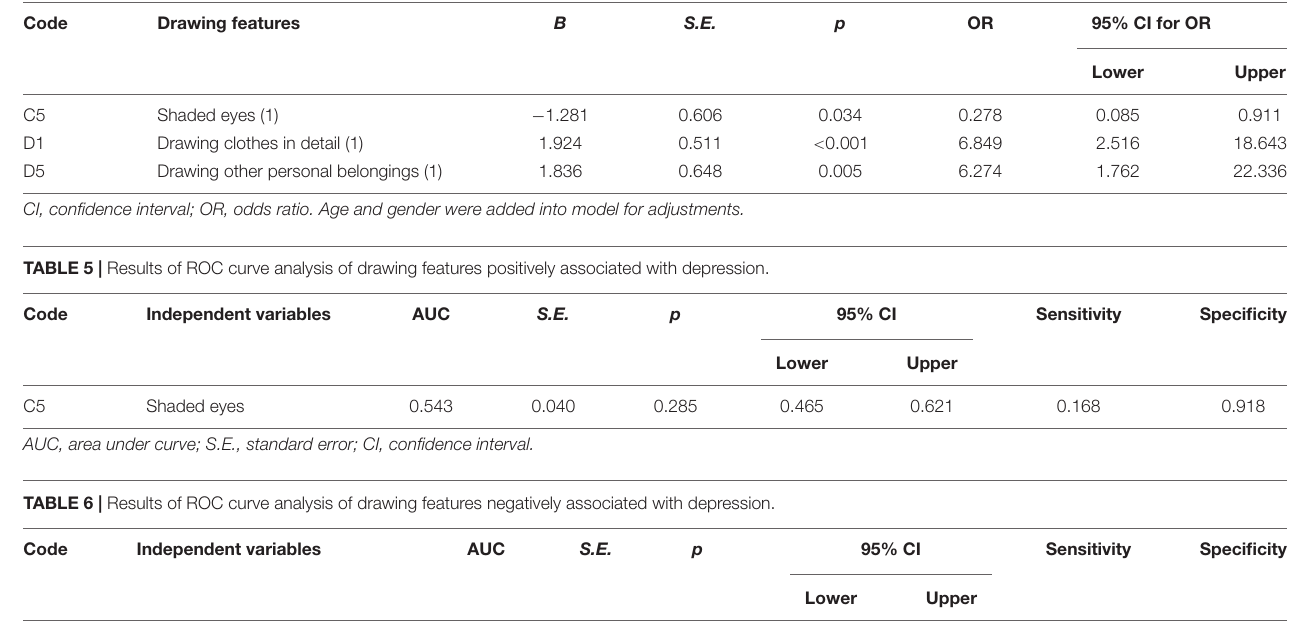
TABLE 4 | Logistic regression analyses of drawing features.